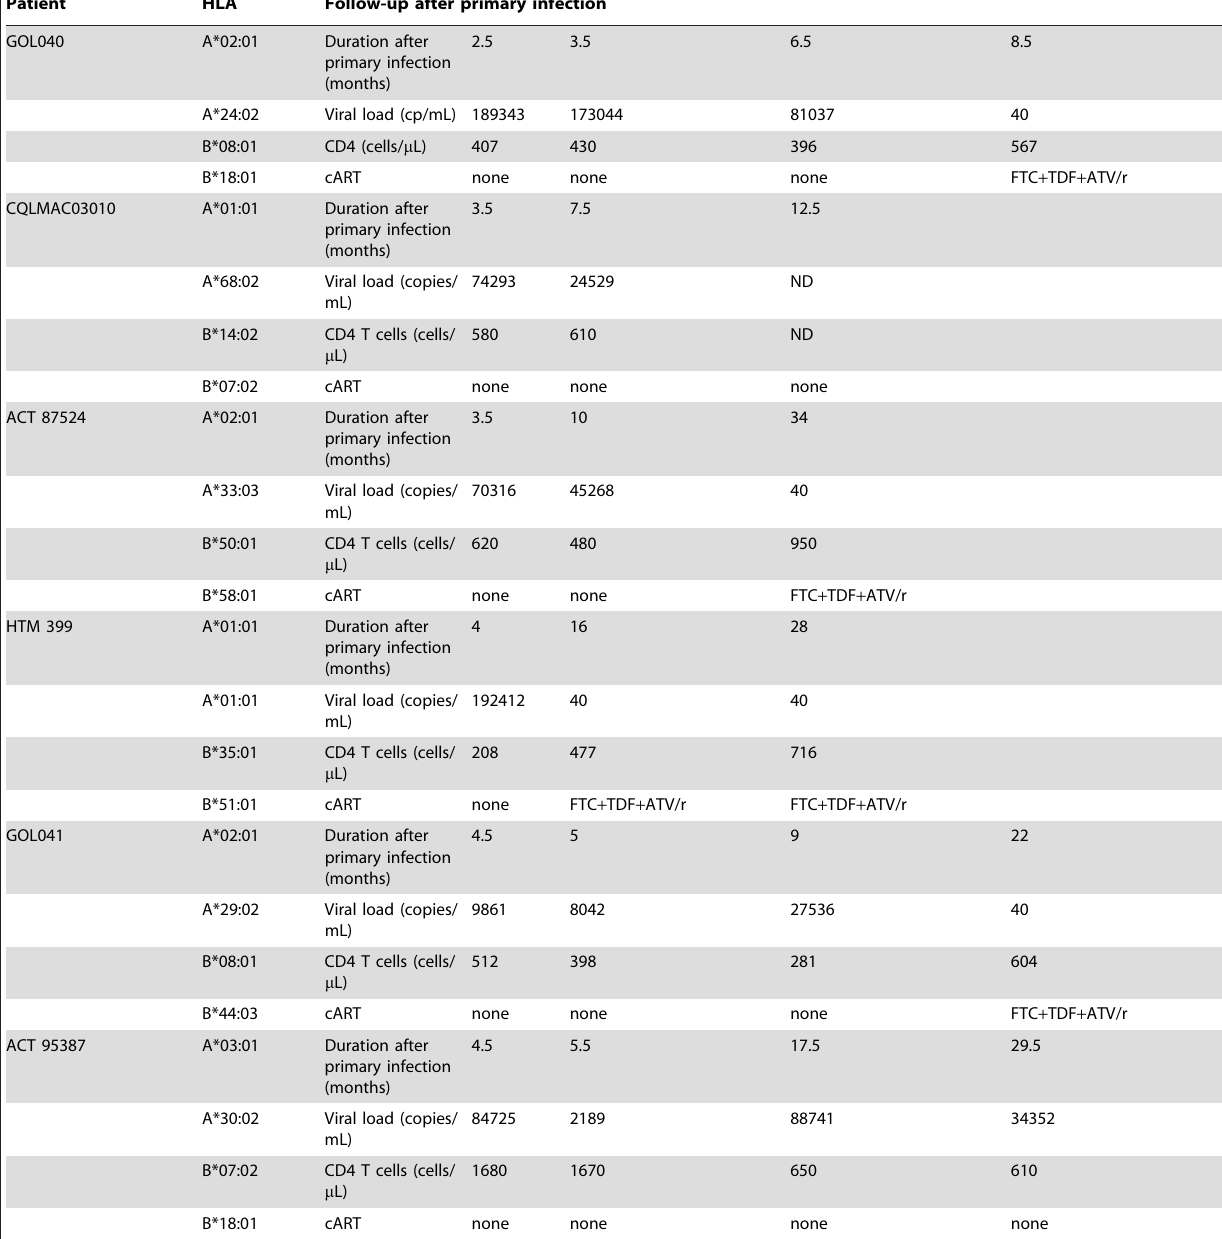
Legend to Table 2 to 7B: The CTL epitopes that should be recognized according to the HLA alleles are defined using the HXB2 reference. The observed corresponding epitopes in the different samples are described either for RNA or DNA. The dates are the dates of sampling. « Id » indicates that the epitope observed is identical to the HxB2 reference. The numbers in parenthesis are the theorical MHC IC 50 (nM) according to simulation of affinity between the epitopes and the HLA alleles. The numbers in parenthesis and italic represent percentages of RT variants determined by UDPS.